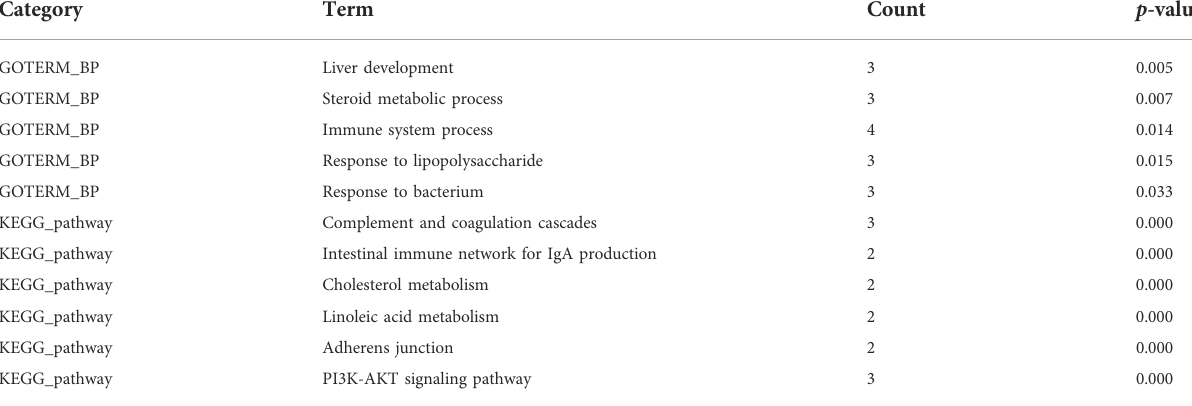
TABLE 5 GO_BP annotation and KEGG pathway analysis of nodes in cluster